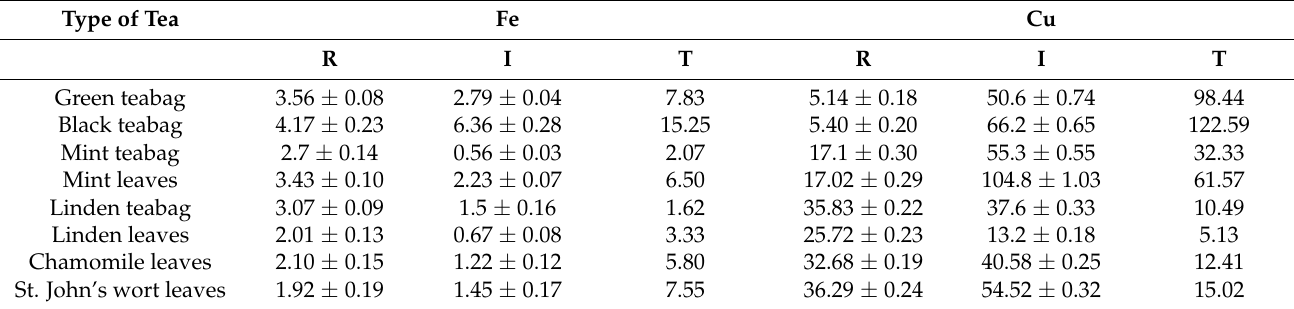
The analysis of trace elements in tea leaves is necessary to control the quality of tea because agricultural and climatic characteristics, mostly related to soil conditions, as well as the processing manufacturers of the tea, influence the composition [34,35]. The most plentiful trace elements in teas are Fe and Cu [36]. The content of each element (Fe and Cu) was measured in the dry material (mg/kg) and in the corresponding infusion (2 min of infusion time) ( µ g/L). Fe and Cu content and the transition rates (%) are given in Table 3. Table 3. Fe and Cu concentrations in raw materials ( x ± SD ) R (mg/kg), infusions ( x ± SD ) I ( µ g/L) and transition rates T